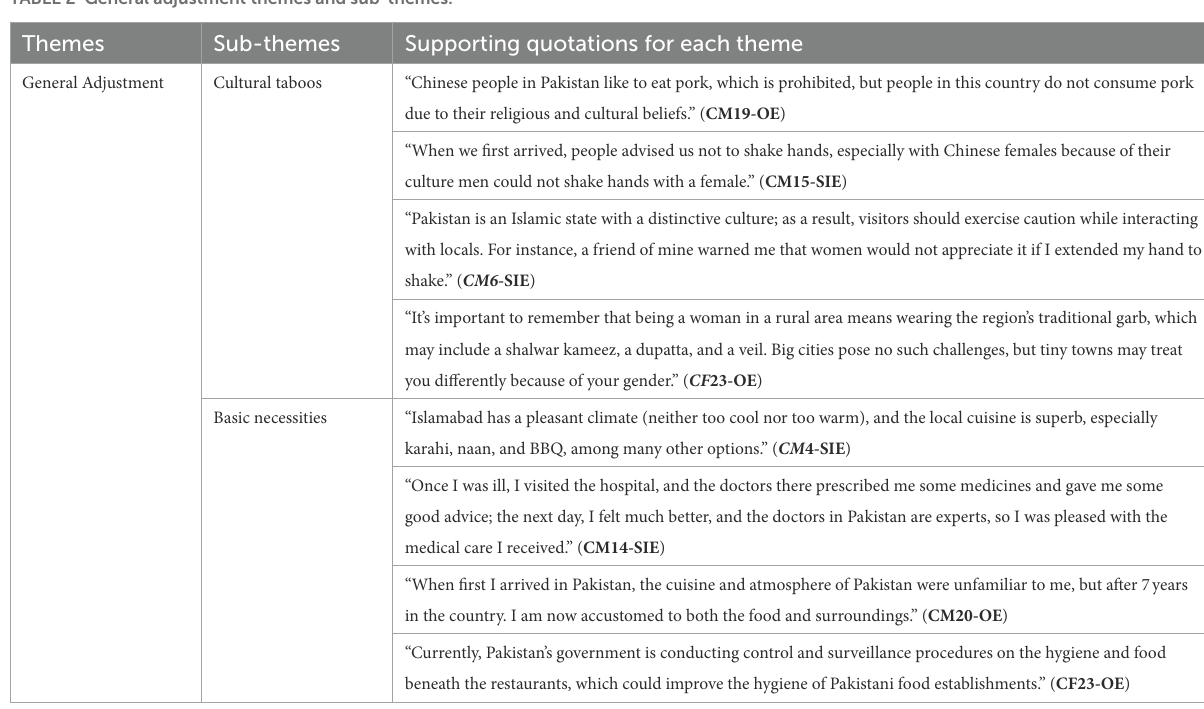
TABLE 2 General adjustment themes and sub-themes.